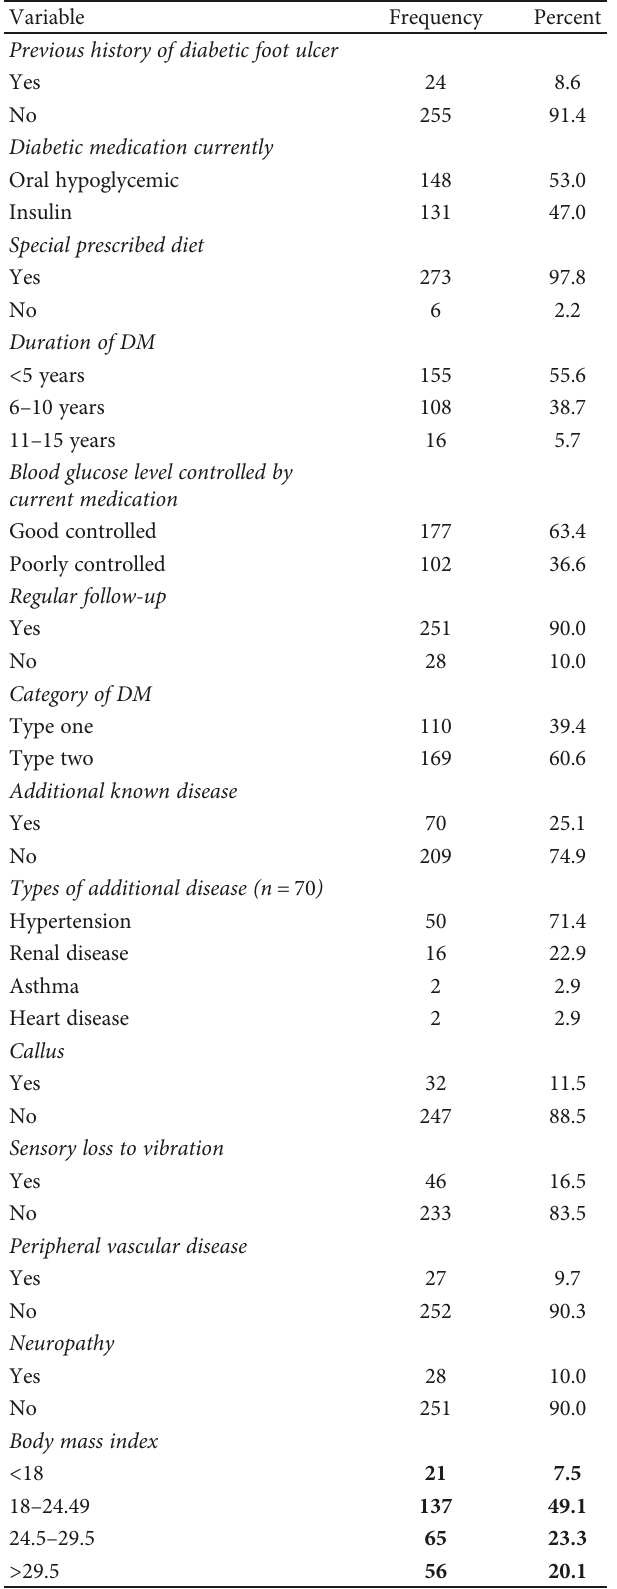
Table 2: Clinical factors of respondents in Gondar University Referral Hospital, Northwest, Ethiopia, 2016 ( n = 279 ).